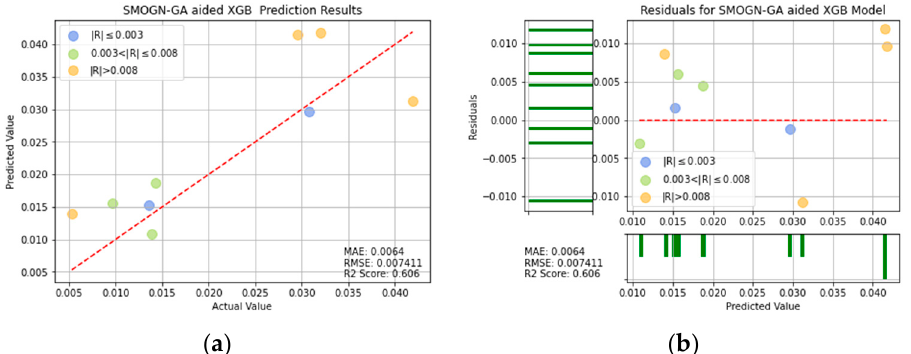
Figure 19. SMOGN-GA-XGB prediction results: ( a ) comparison of actual and predicted precision values, and ( b ) residual plot.